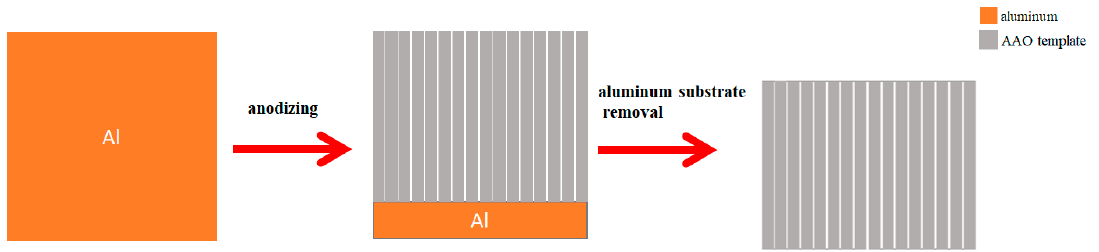
Figure 1. Schematic representation of the synthesizing procedure for preparing the AAO template.